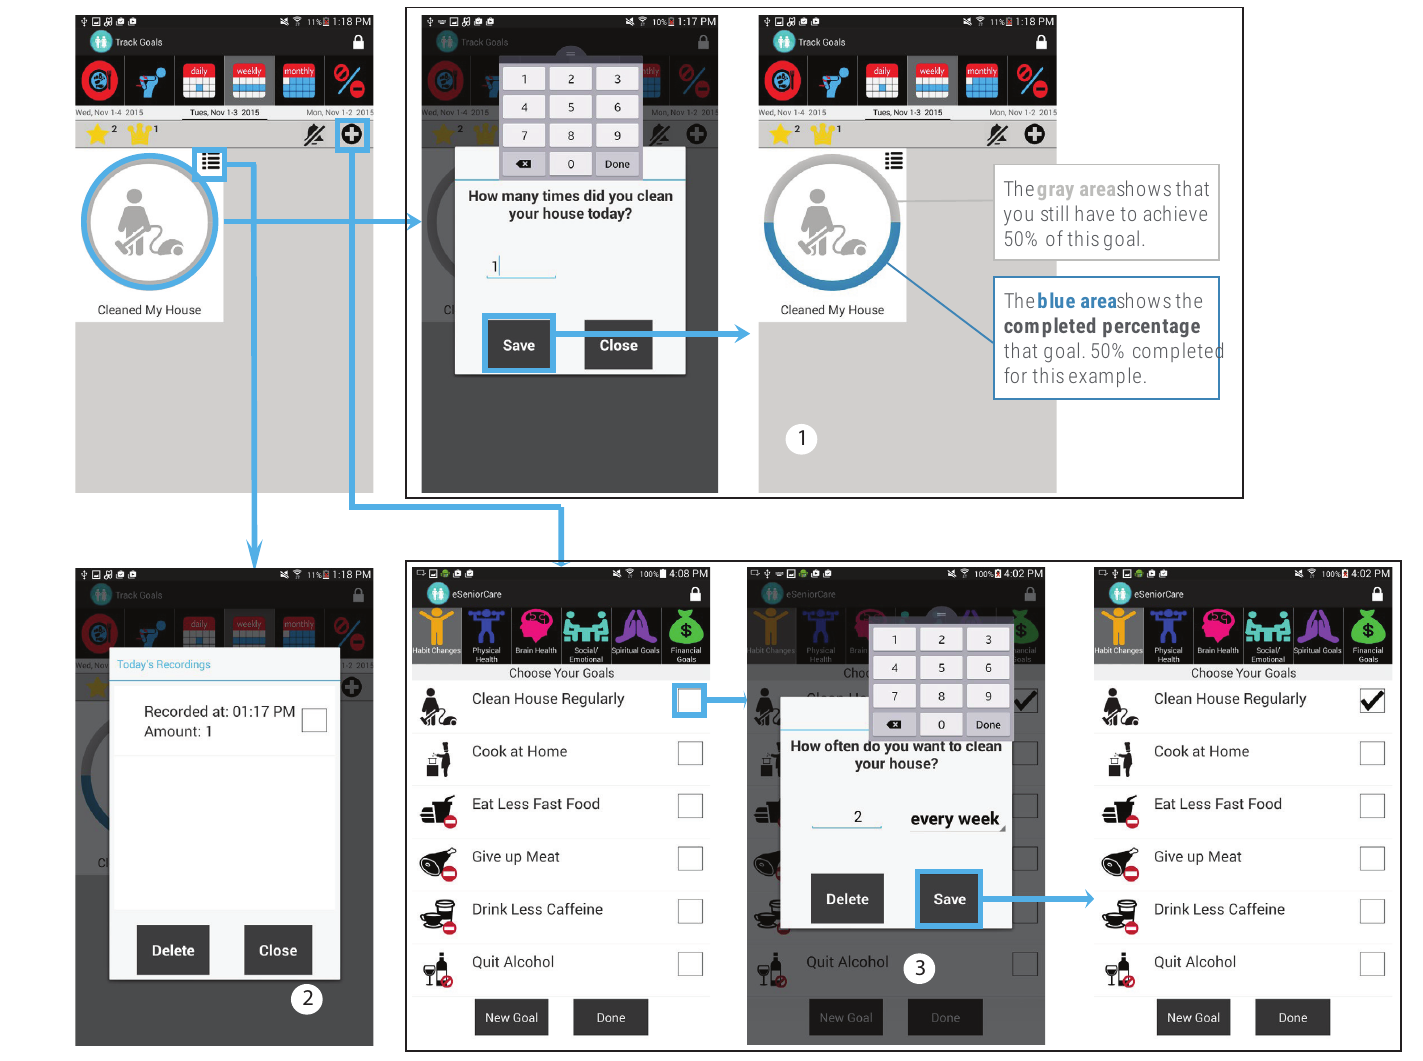
Figure 2. Features of eSeniorCare’s goal component. ( 1 ) Goal tracking process, ( 2 ) Viewing tracking history, and ( 3 ) Goal setting